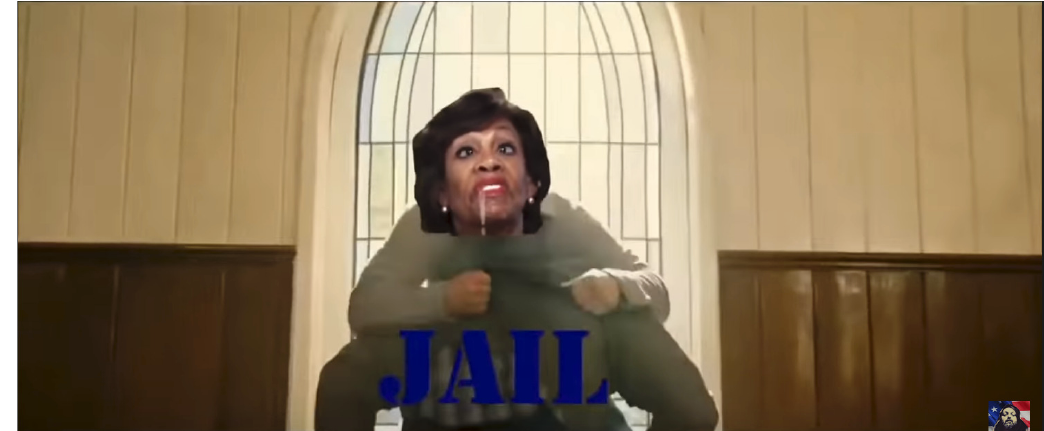
Representative Maxine Waters, a black woman, is shown being hurled from a window marked “JAIL” as seen in Figure 4. Recently deceased at the time, Republican party rival John McCain is brutally pistol‐whipped. Former political rival Bernie Sanders is shown screaming as Trump sets his hair on fire.